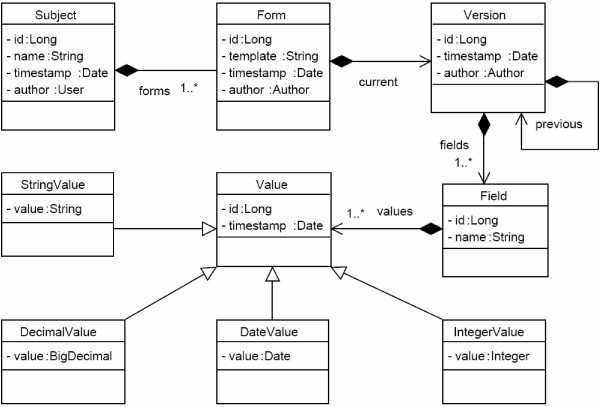
PDS UML Class Diagram.